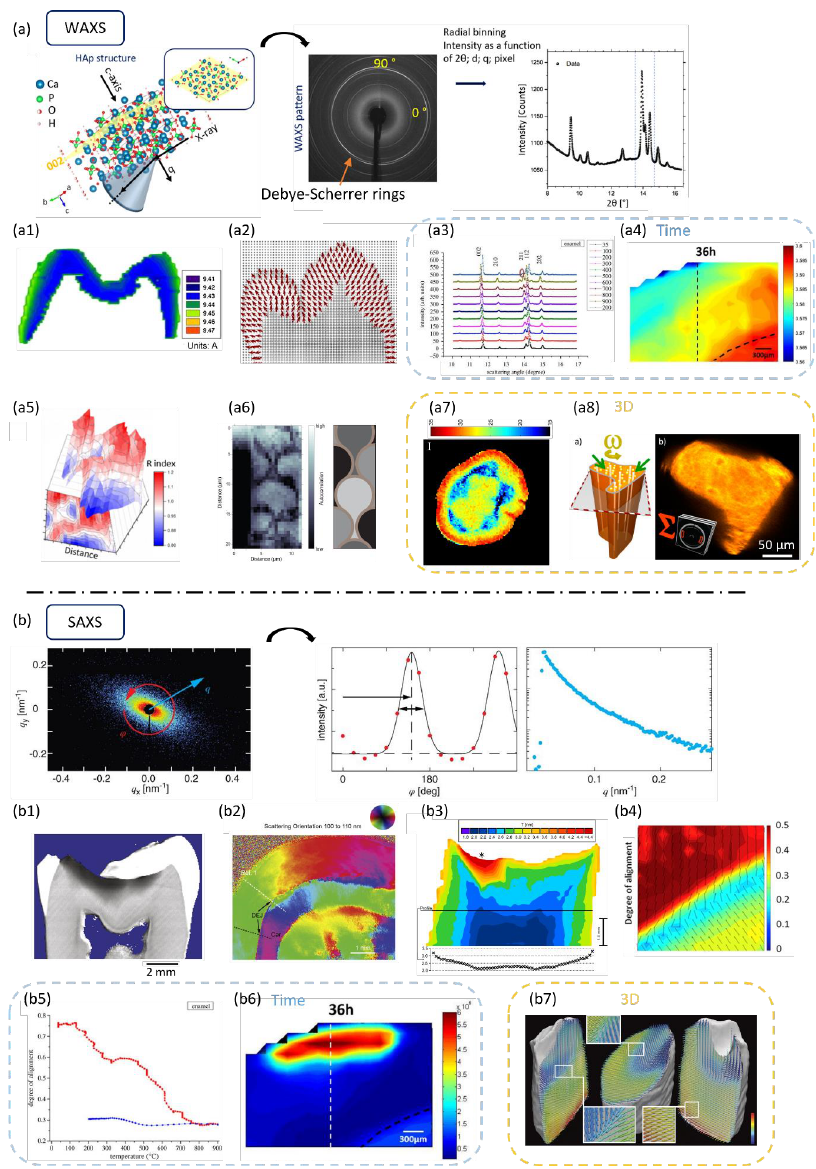
Figure 6. Illustration of WAXS and SAXS synchrotron application to human teeth. ( a ) Crystal structure of HAp and WAXS analysis with details of the signal and formation of the Debye–Scherrer ring, adapted from [56], license https://creativecommons.org/licenses/by/4.0/ accessed on 30 March 2023, and applications with ( a1 ) distribution of the a-lattice parameter in dental human enamel (adapted from [90] with permission. Copyright 2013, Elsevier). ( a2 ) The texture map of the hydroxyapatite crystallites in human enamel based on the (002) peak (adapted from [89] with permission. Copyright 2007, Elsevier). ( a3 ) Diffractograms of enamel under heating and cooling treatments (reproduced with permission from Sui T. et al. [425]). ( a4 ) Evolution of the d-spacing of human enamel during acid exposure (adapted from [170] with permission. Copyright 2018, Elsevier). ( a5 , a6 ) Sub-micron resolution maps of human enamel with and without demineralisation (adapted from [56], license https://creativecommons.org/licenses/by/4.0/ accessed on 30 March 2023, and adapted from [354] with permission. Copyright 2020, Cambridge University Press). ( a7 ) Virtual slice from 3D diffraction tomography of human carious tooth showing nanocrystalline size in nanometres (adapted from [448] with permission. Copyright 2013, Elsevier). ( a8 ) 3D diffraction tomography, showing the apatite orientations in human dentine with colour map assigned to the intensity (0 to 1 arb. units) adapted with permission from [420]. Copyright 2015 American Chemical Society). ( b )